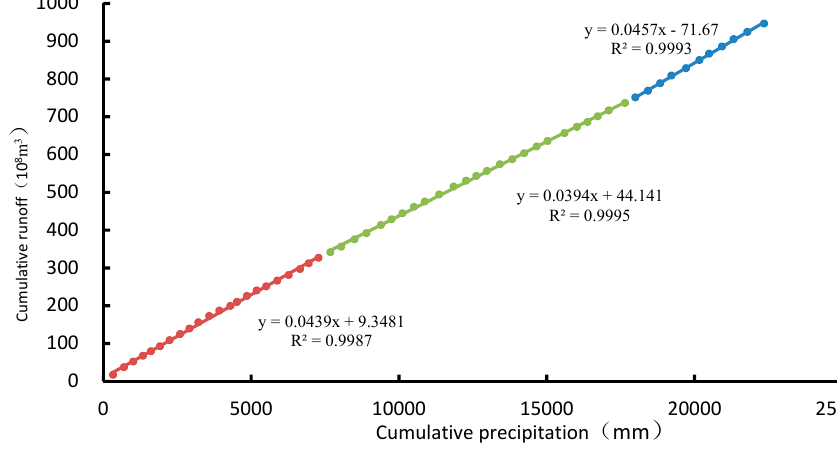
Figure 6. The precipitation-runoff DMC.